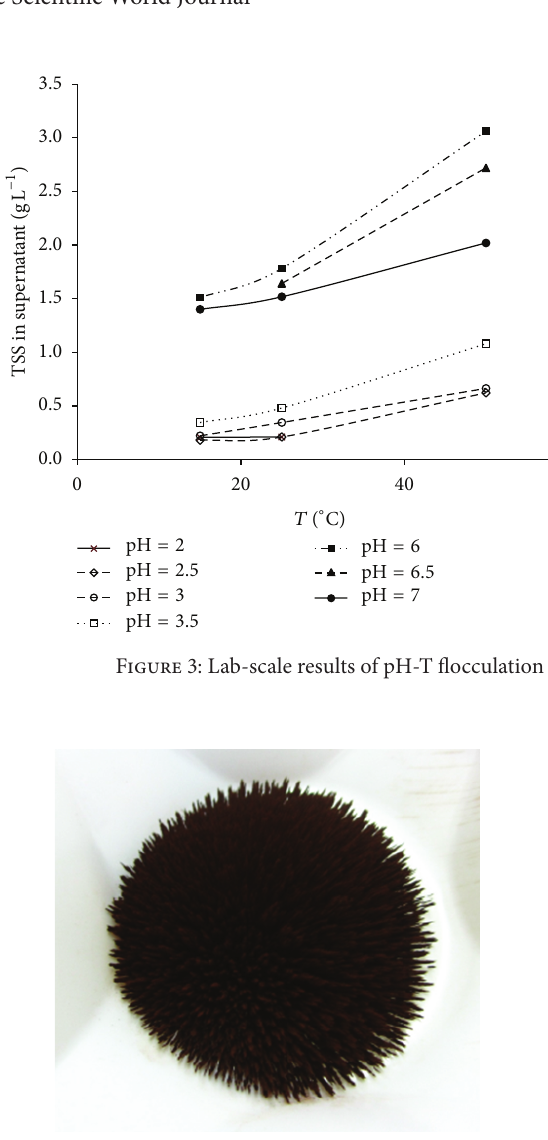
Figure 4: Photography of the ferromagnetic photocatalytic nano-